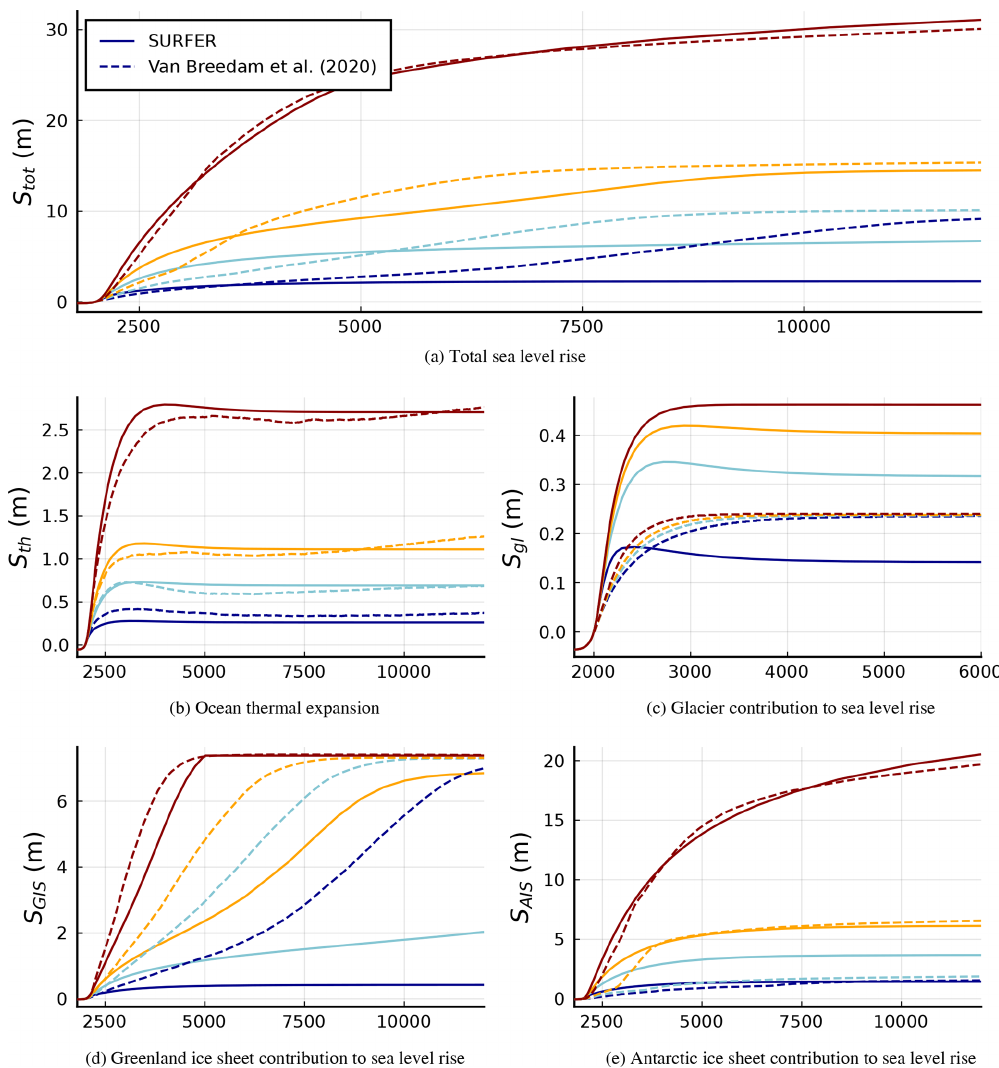
Figure 16. Long-term sea level rise from SURFER and Van Breedam et al. (2020) when forced by extended RCP scenarios. Solid lines correspond to SURFER and dashed to the results in Van Breedam et al. (2020). Colours indicate different RCP scenarios as in Fig.